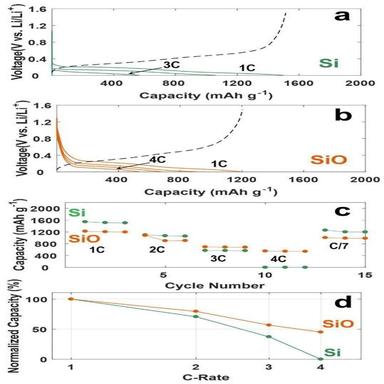
Fast charging rate capability of Si and SiO anodes. Voltage profiles of (a) Si and (b) SiO anodes, (c) their specific charge capacity retentions, and (d) variations in normalized charge capacities depending on C-rates at 25 °C. A constant current with C/7-rate was applied during discharging.